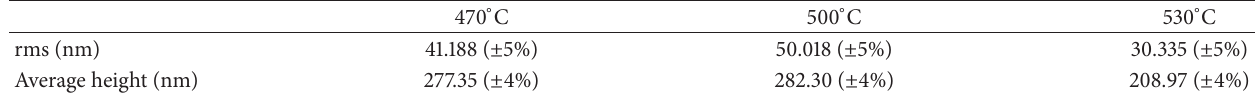
Figure 3: 3d AFM surface images of iron telluride films (470 ∘ C ( 𝑖 ), 500 ∘ C ( 𝑗 ), and 530 ∘ C ( 𝑘 )). Table 1: Layers mean surface roughness and average height versus substrate